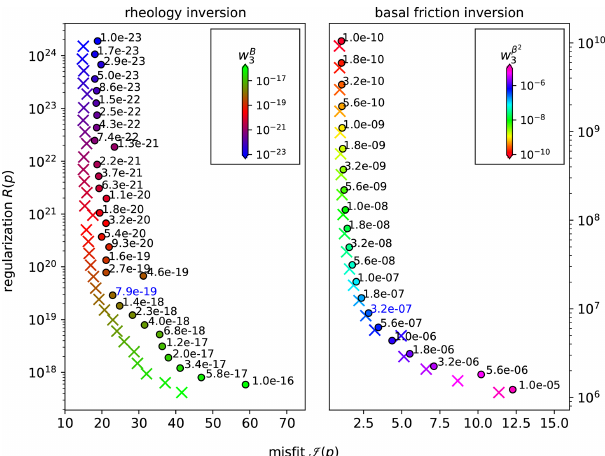
Figure A1. L-curve analysis to derive best values for the regular- ization parameter for the rheological parameter and the basal fric- tion coefficient. The chosen values are displayed in blue. Crosses show results from the MEaSUREs velocity field and circles from our Landsat-8 velocity